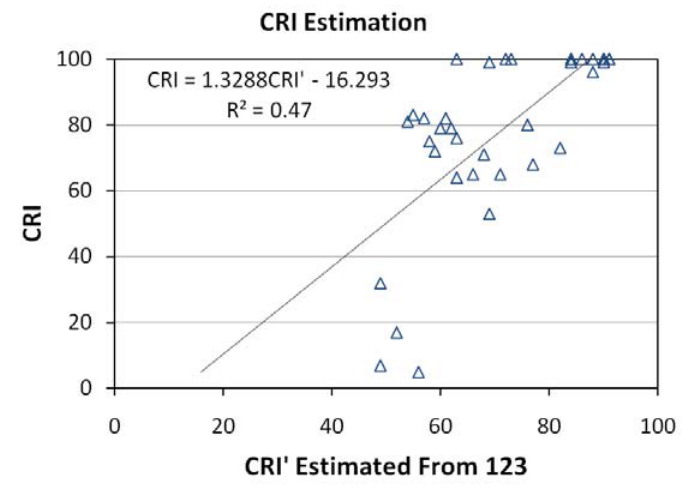
Figure 26. CRI versus estimated CRI’ using TM bands 1, 2 and